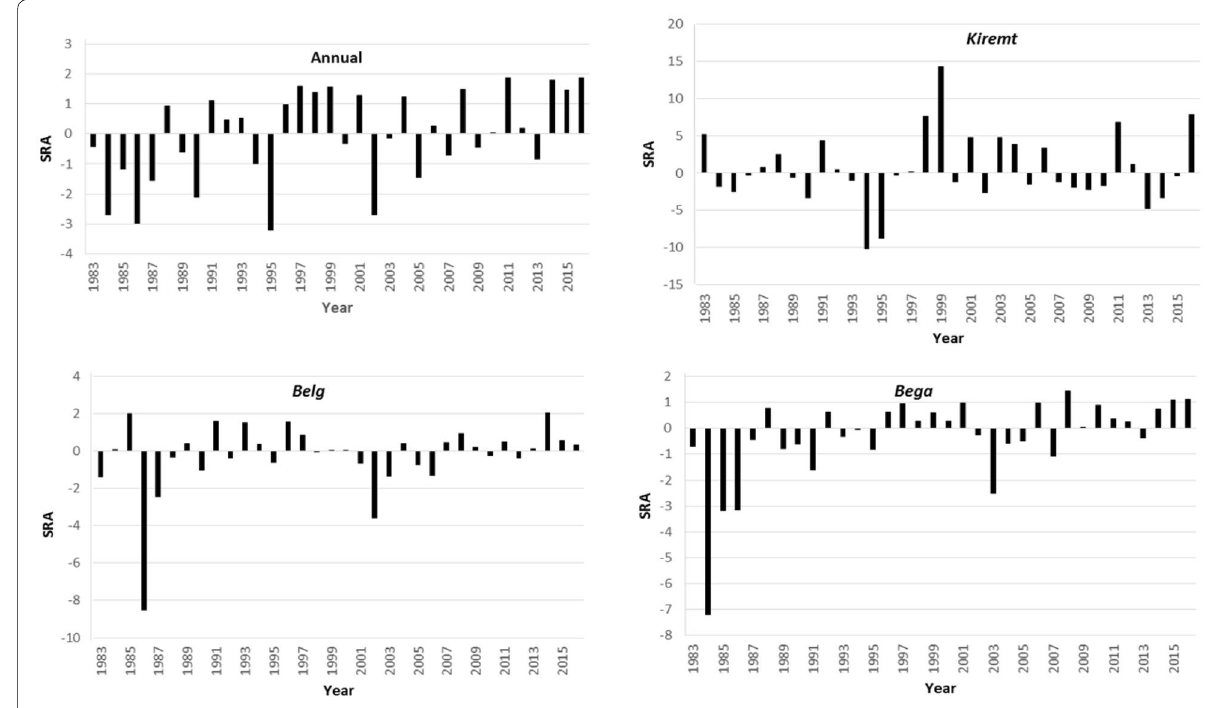
Fig. 3 Temporal variations in the seasonal and annual rainfall anomalies in Alwero